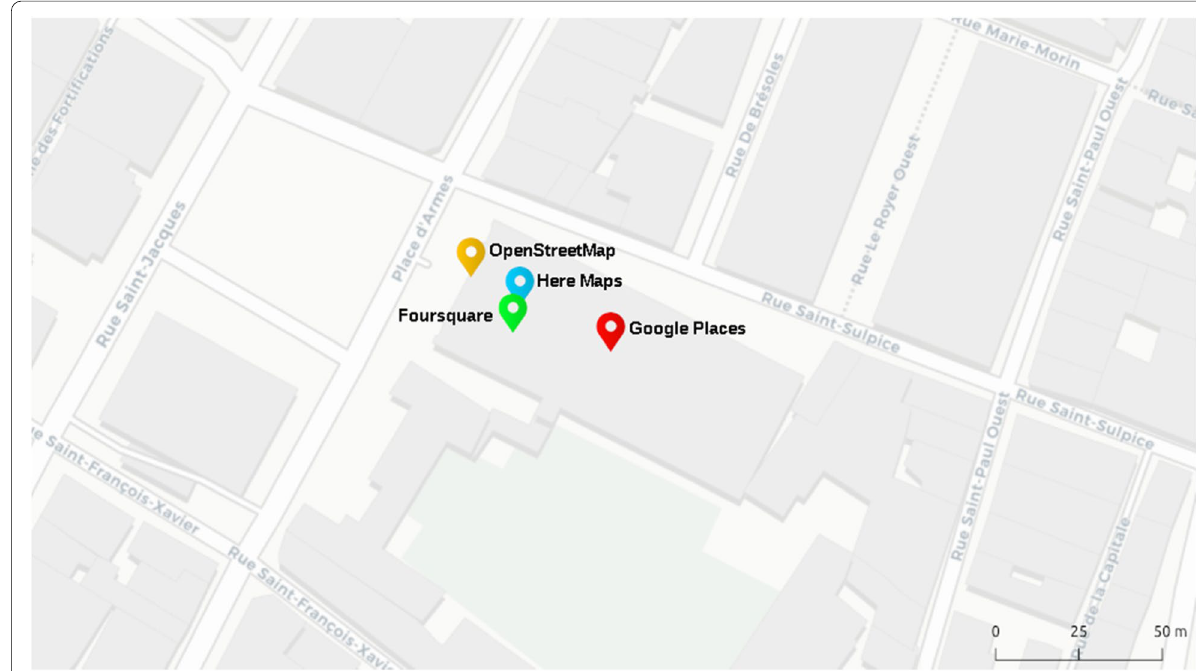
Fig. 2 Four POI‑based digital representations for the same real‑world location (Notre‑Dame Basilica in Montreal). Each point is labeled by the POI provider. Base map by CARTO/OpenStreetMap